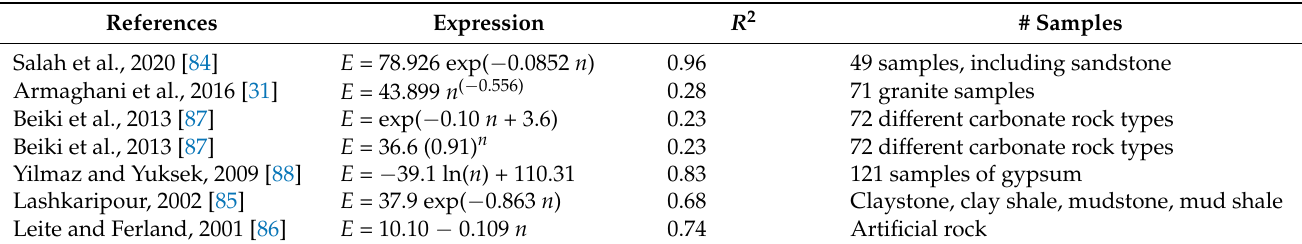
Figure 11. Elastic moduli (note: σ denotes standard deviation).